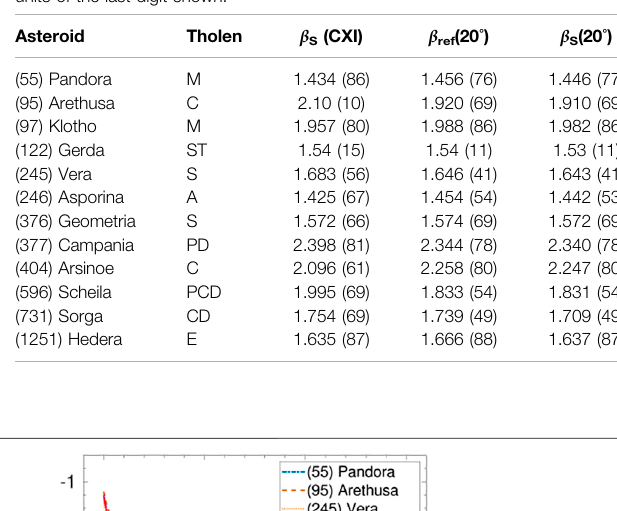
TABLE 2 | The photometric slope β S (mag/rad) of the phase function retrieved using convex inversion by Martikainen et al. (2021) (CXI), together with the mean-magnitude reference phase curve slope β ref (mag/rad) and the slope β S (mag/rad), both computed for the phase angle of 20 ° . All the slope parameters represent the means from MCMC sampling. The uncertainties are given in units of the last digit shown.